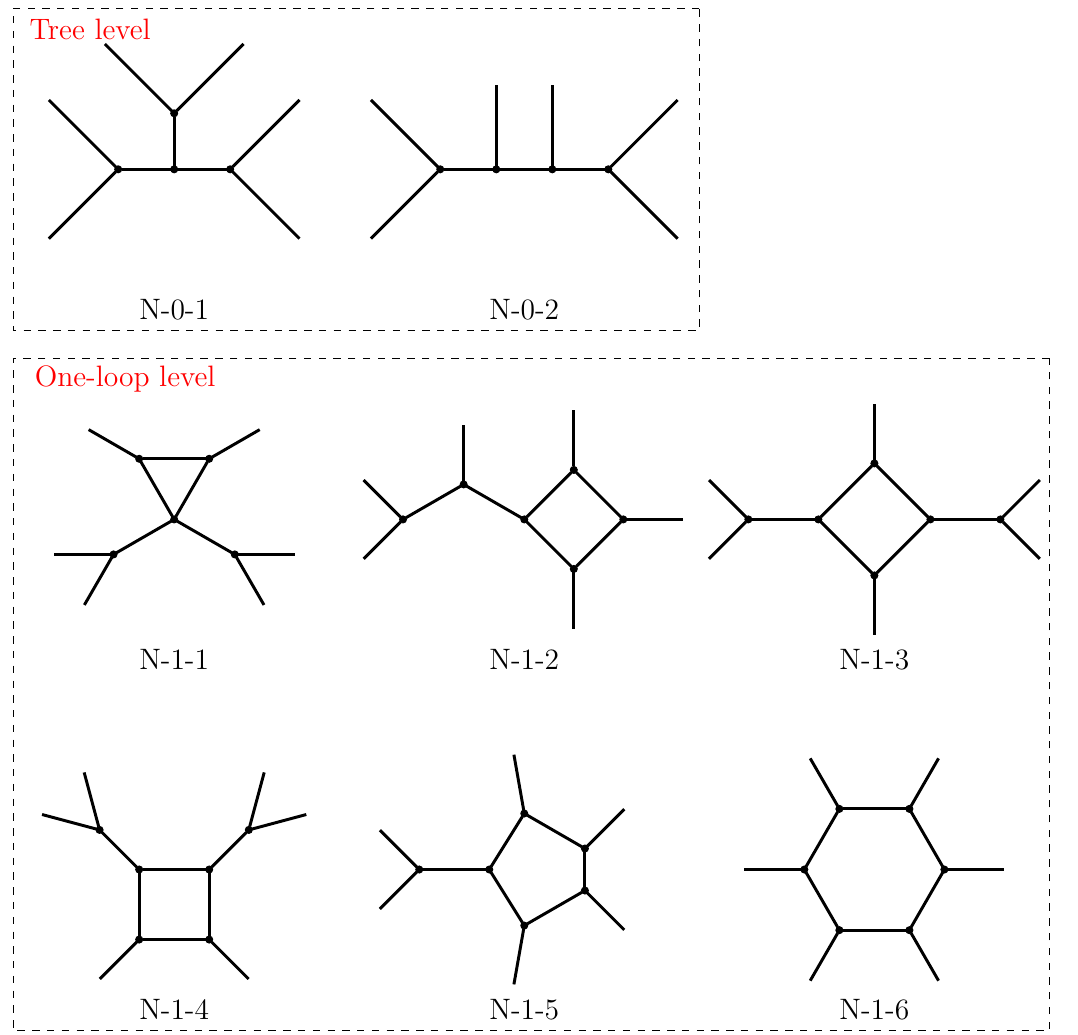
Figure 1 . Genuine topologies which can lead to tree-level and one-loop genuine models for the short-range part of the 0 νββ decay